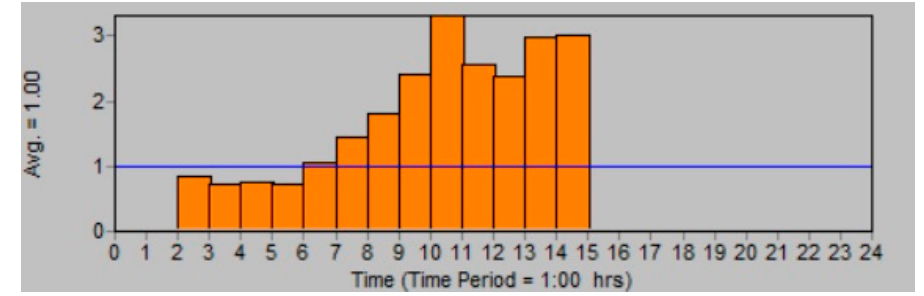
Figure 4. Daily water consumption pattern for a selected industrial customer.